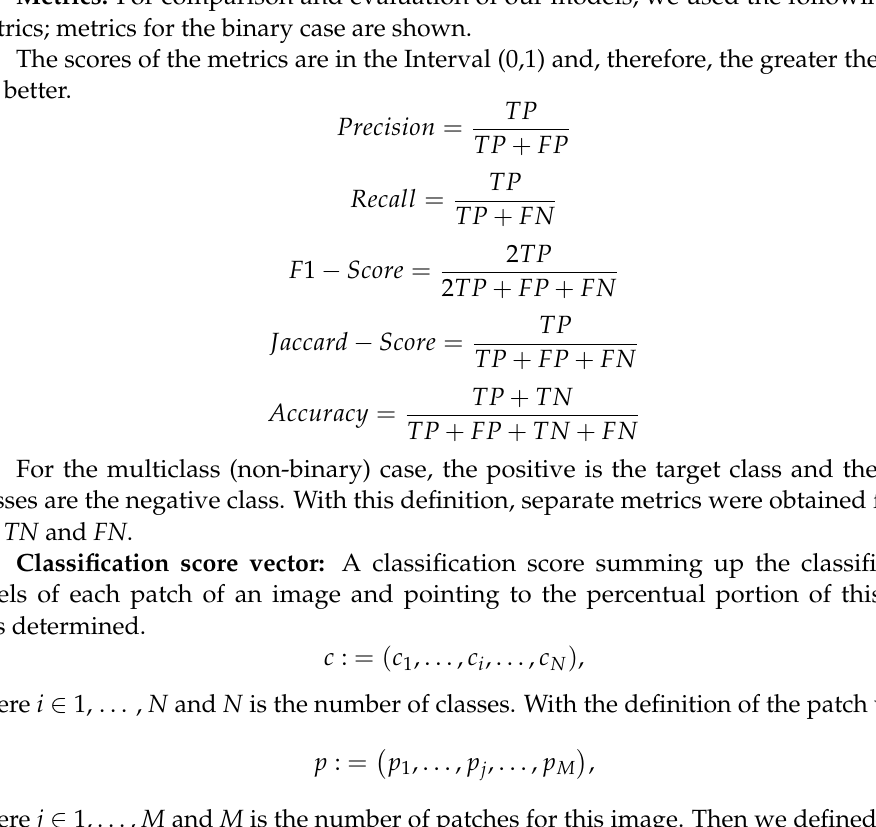
Three score: For a second score to rank the networks, we calculated the percentages of the right label prediction. The average of image tiles of a group (HLN, HP, PDAC) on the test data was determined. Four score: A segmentation tool was used to rank different networks on the validation dataset, by a pathologist [27]. The average of image tiles of a group (HLN, HP, PDAC and LNPM) was determined and compared to the pathologist’s label as ground truth. Images with insufficient labeling were excluded, as